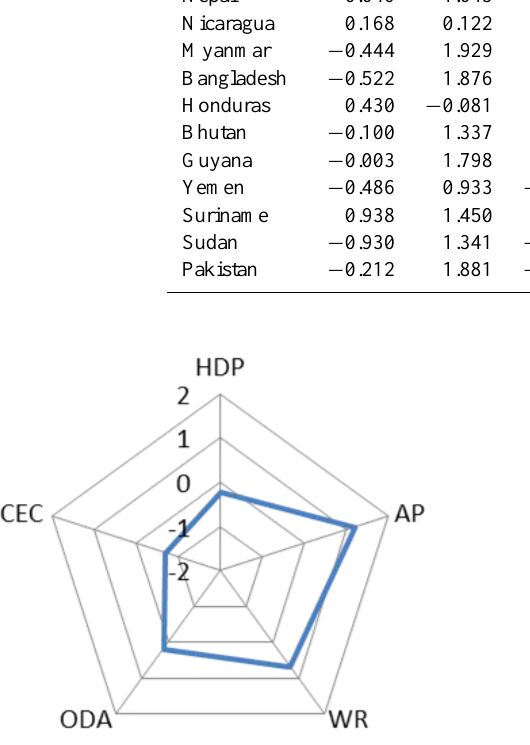
Fig. 7. Profile 3 – mainly organised around agriculture (AP), often irrigation, the countries in this profile show limited human develop- ment (HDP) with low accountability and concern for the environ- ment (CEC). An important gap in basic sanitation access is observed that steps generally far behind water supply access.